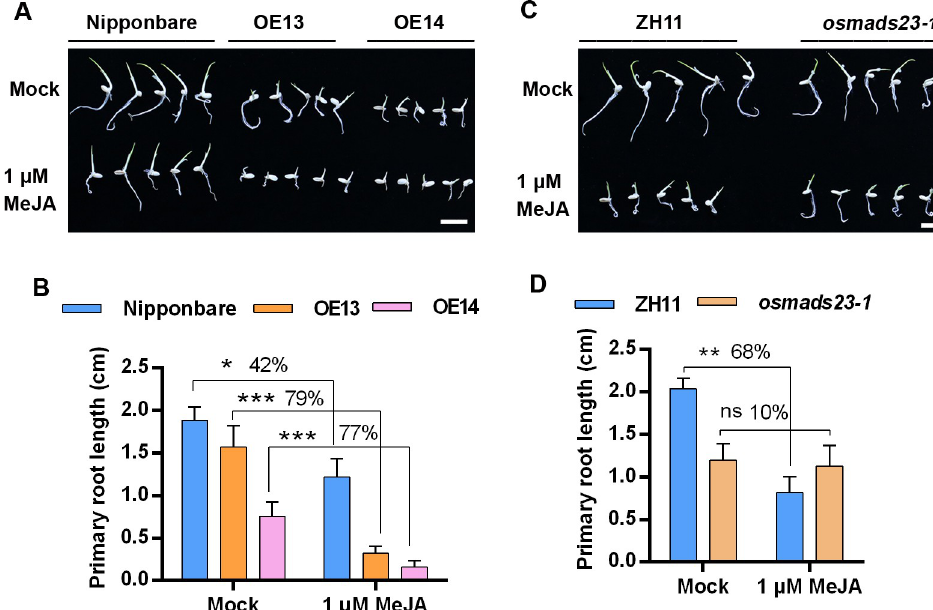
Fig 7. OsMADS23 mediates JA sensitivity indicated by primary root growth inhibition assay. (A,C) Images showing the responses of the wild type (Nipponbare) and OsMADS23 overexpression lines (A), or wild type (ZH11) and osmads23-1 mutant (C) to exogenous MeJA. Scale bars, 1 cm. Uniformly germinated seeds were grown on 1/2MS medium with or without MeJA for 2 days. (B, D) Statistical analysis of the primary root length of indicated plants in (A) and (C), respectively. Data are means ± SD ( n = 15). In (B) and (D), the significant difference between the treated and untreated plants was determined by Student’s t test. � p < 0.05, �� p < 0.01 or ��� p < 0.001. ns, not